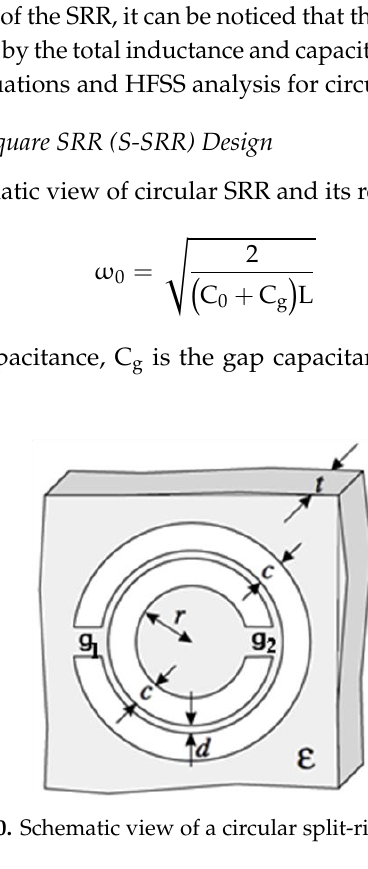
Figure 9. SRR equivalent circuit model.